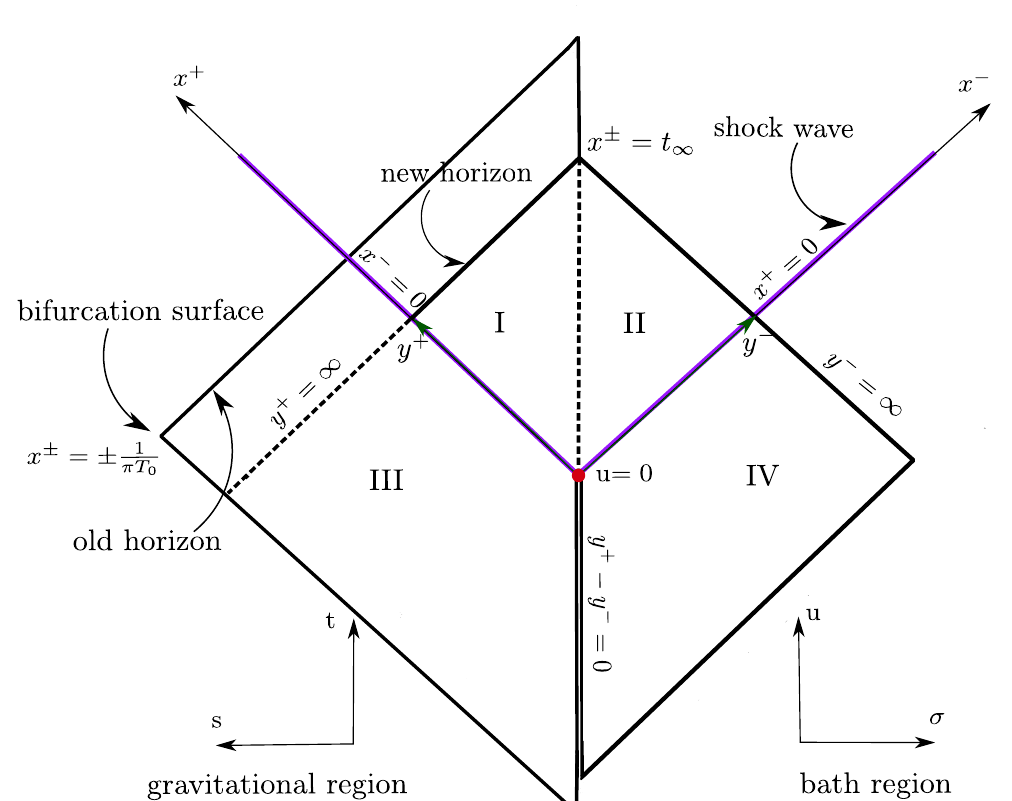
Figure 3. This figure shows the Poincare patch of a black hole in AdS 2 which is glued to the thermal bath in flat spacetime along the boundary σ = 0 at time u = 0 . The purple lines are the shock waves that are generated by this quench. This picture also shows the location of the bifurcation surface and the horizon of the initial equilibrium black hole as well as the new horizon which is shifted w.r.t. the old one due to the propagating shock